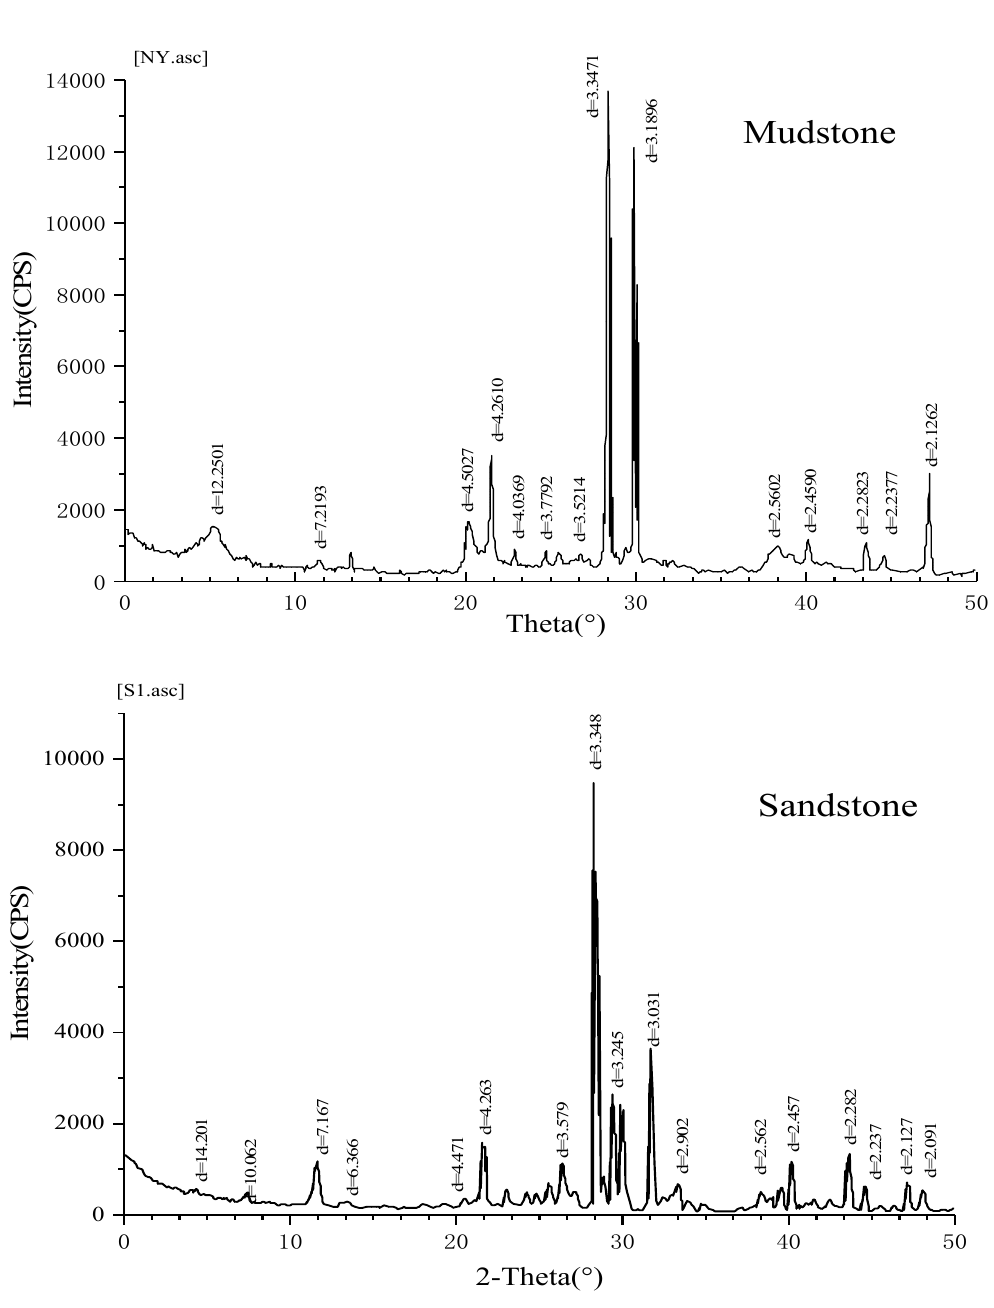
Figure 4. X-ray diffraction analysis of mudstone and sandstone specimens.